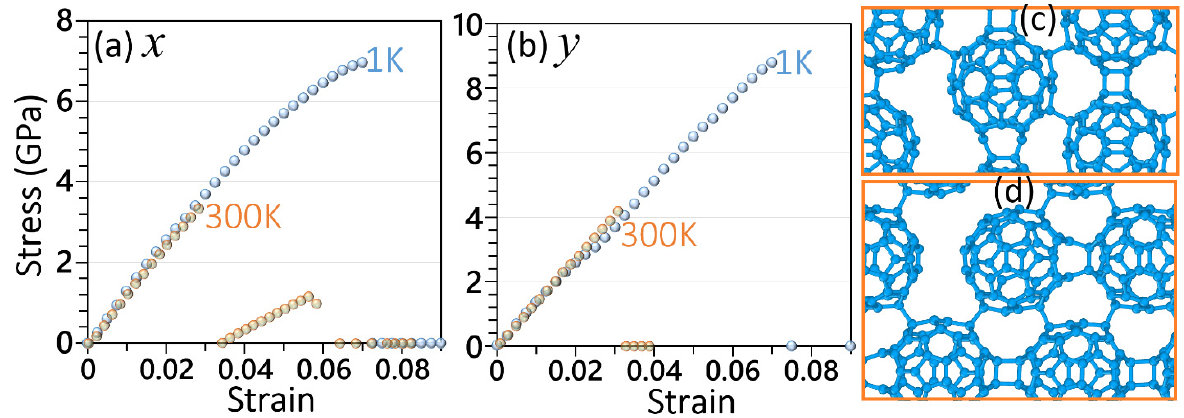
Figure 3. Predicted uniaxial stress–strain responses of the qHPC 60 monolayer by MTP-based molecular dynamics simulations carried out at 1 and 300 K along ( a ) x and ( b ) y directions. Close-up view for the failure mechanism for the uniaxial loading along ( c ) x and ( d ) y directions plotted using the OVITO package [37] (for the related videos refer to the data availability).